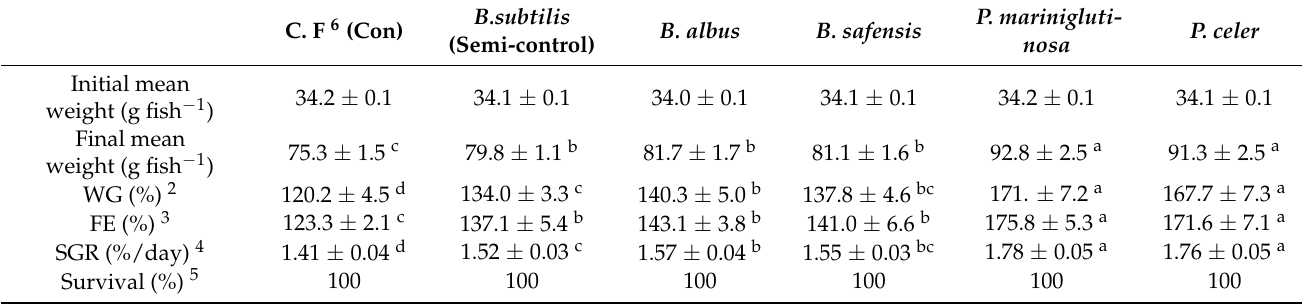
Table 1. Growth performance of Amur catfish fed with commercial feed and 5% freeze-dried bacteria biomass-supplemented feed at end of 8-week experiment 1